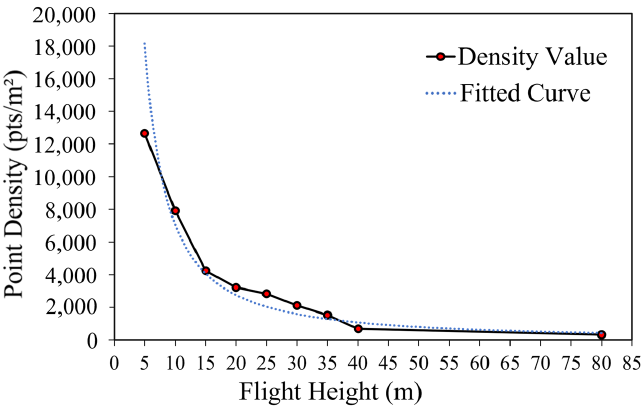
Figure 16. The LiDAR point densities corresponding to different UAV flight heights.